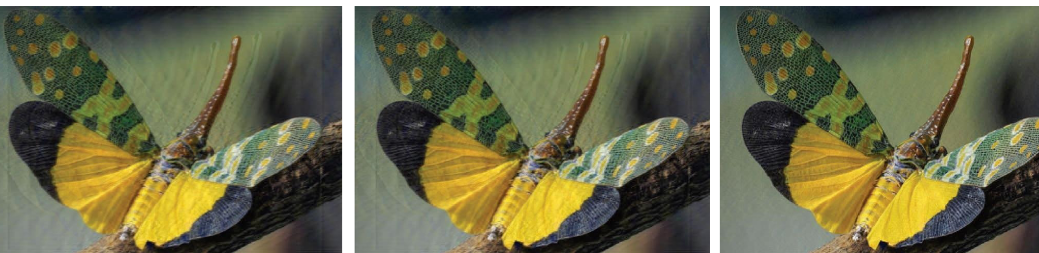
th , 1 , 000 th , and 20 , 000 th used M being 50